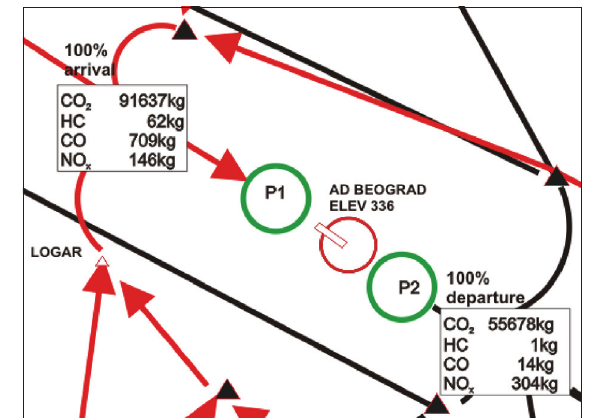
Fig. 12. The proposed scenario 2 of air traffic assignment